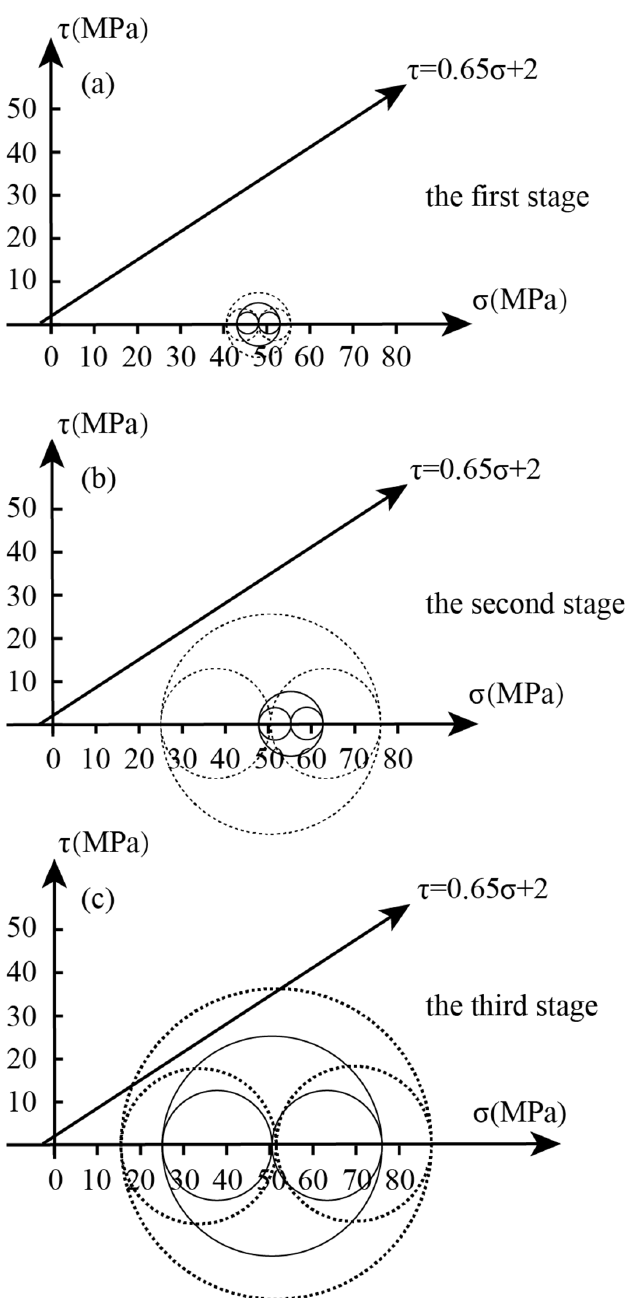
Figure 9. Stress state of natural fracture around the fracturing point after each stage: ( a ) first stage; ( b ) second stage; ( c ) third stage.